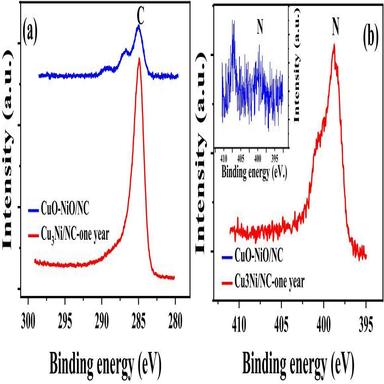
Comparison of configurations of C and N in the XPS results of CuO-NiO/NC-600 and Cu3Ni/NC-600-one year materials.